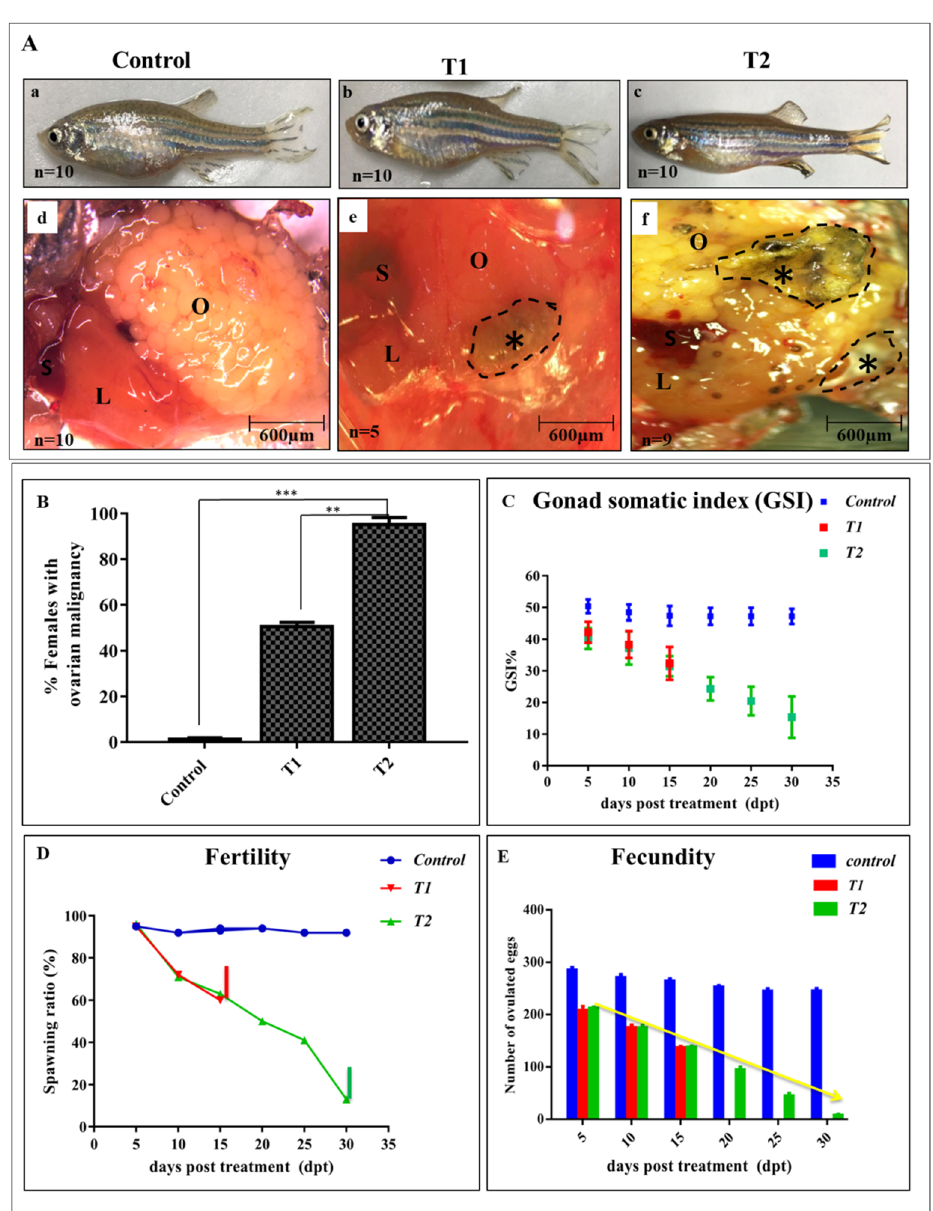
Figure 2. Effects of ZnO-NPs on Gonadosomatic index, fertility, and fecundity: ( A ) Representative pictures of the control, T1, and T2 females with normal ovaries in the control fish ( a , d ), transition state of malignancy in T1 ( b , e ), and ovarian necrosis in T2 ( c , f ) (Black asterisks). ( B ) Percentage of females with macroscopic ovarian malignancy for each experimental group ( n = 10). ( C ) Distribution of gonad somatic index (GSI); notice the weight reduction of T2 females compared with the control. ( D ) Fertility assessment of the control, T1, and T2 groups declined at 30 dpt in T2 into 10%. ( E ) Tracing assessment of fecundity in the control, T1, and T2 with a significant reduction in T2 at 30 dpt. L: liver, O: ovary, S: spleen. The results are shown as the mean ± SEM. * p < 0.05, ** p < 0.01, *** p < 0.001. T1 = group was exposed to 1/5th of estimated LC 50 of ZnO-NPs in water daily for two weeks (15 days). T2 = group was exposed to 1/5th of estimated LC 50 of ZnO-NPs in water daily for one month (30 days).